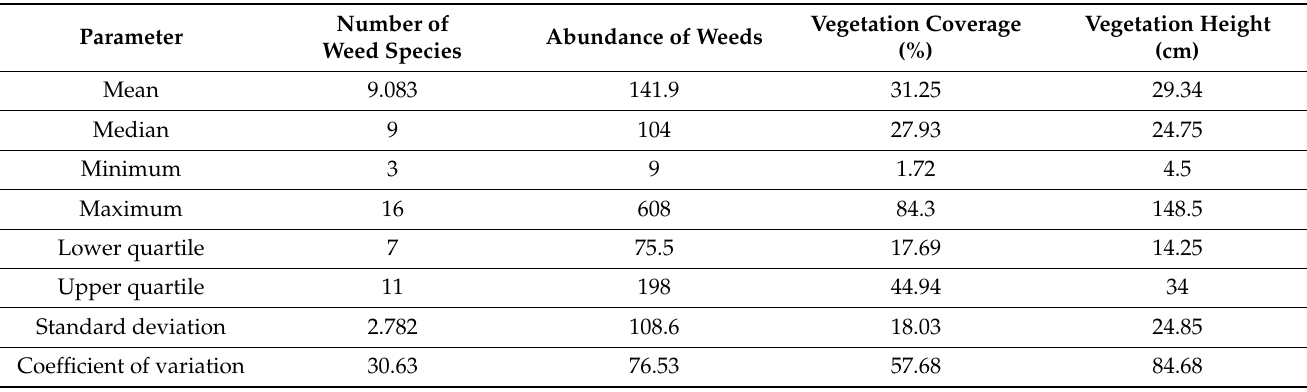
Table 1. Summary statistics of vegetation coverage, vegetation height, number of weed species, and abundance of weeds collected from the field [40–44].